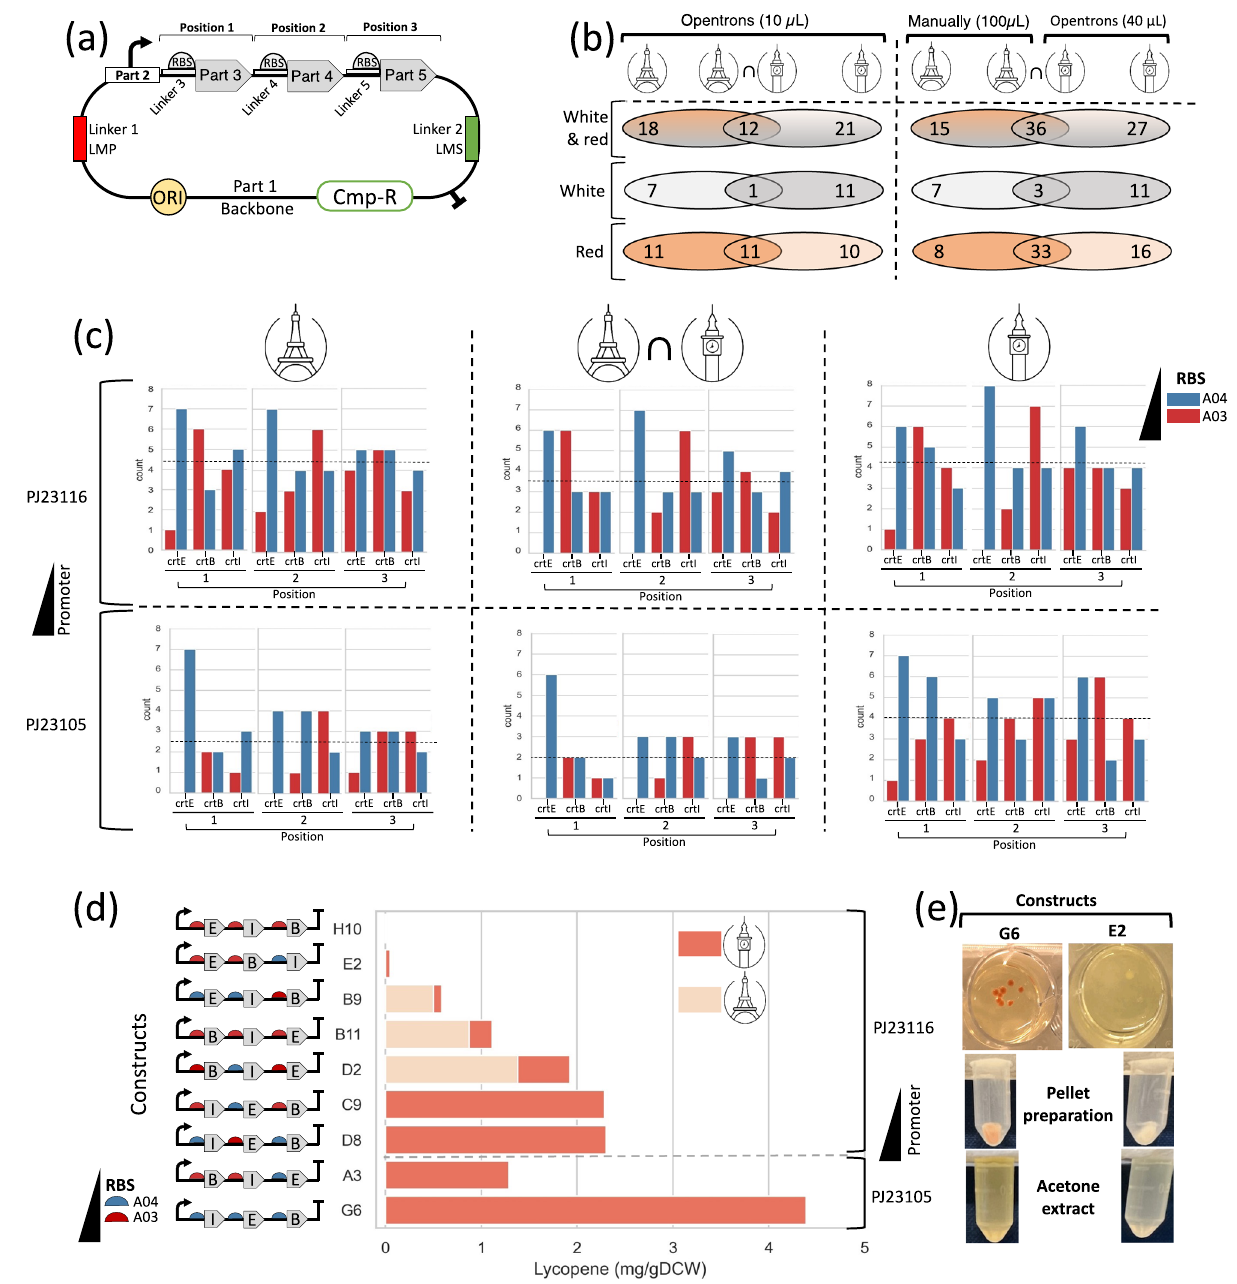
Fig. 1 | Automated construction of 88 distinct plasmids coding for lycopene pathwayoperonscontaininggenesindifferentorders,withvaryingpromoters and RBSes.a Plasmids coding for lycopene genes wereassembled using the BASIC method(withDNAlinkers).Genesinthelycopenepathway, crtE , crtB ,and crtI (parts 3,4,and 5),wereassembled inanoperonwithUTR-RBSlinkerscontainingdifferent RBSes. The promoter (part 2) and the 3-gene operon were assembled into a back- bone with p15A origin of replication (ORI) and chloramphenicol resistance gene (Cmp-R). The assembled parts were fl anked by methylated linkers that recapitulate BASIC pre fi x and suf fi x (LMP and LMS). b Number of constructs with successful transformantcolonies and theircolorarereported fromMicalisInstitute, Paris, and Imperial College, London. Number of constructs common to both laboratories are in the intersection. Data are from spotting 10 µ L of transformation reactions by